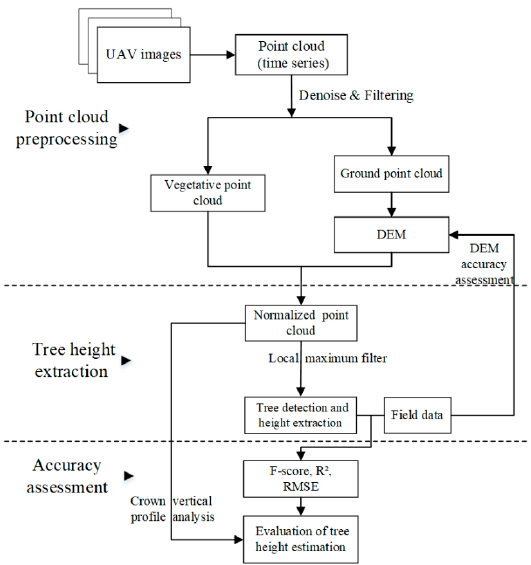
Figure 3. The conceptual workflow for UAV image processing and tree height extraction.